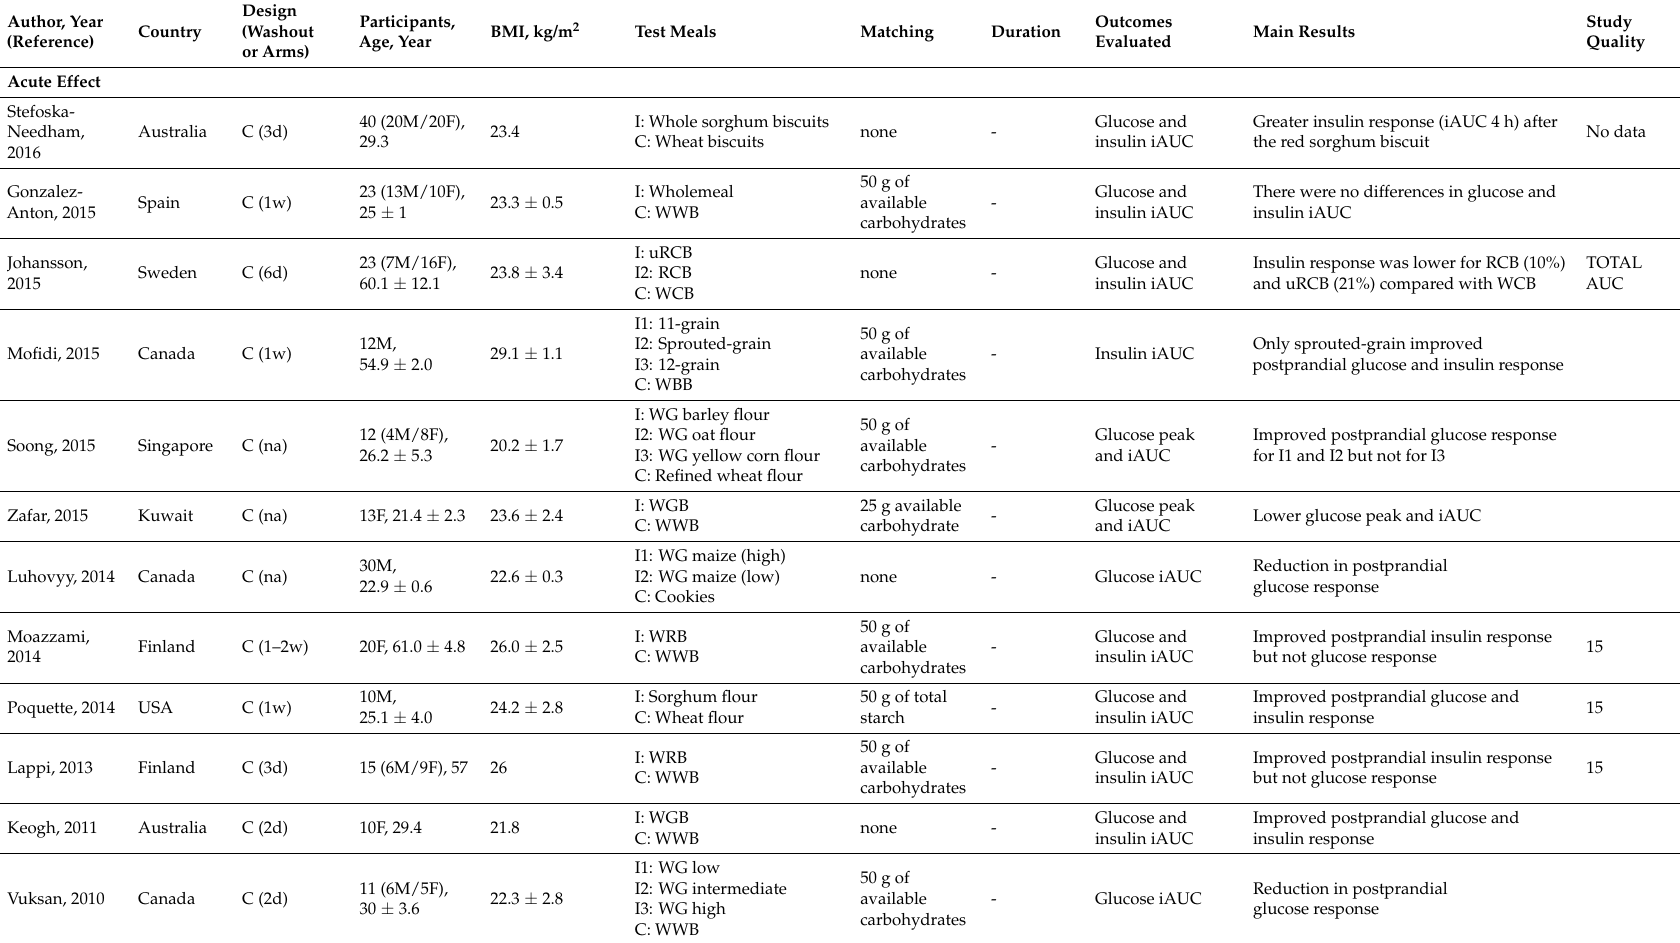
Table 1. Characteristics and main findings of the clinical trials evaluating the effects of WG consumption in healthy